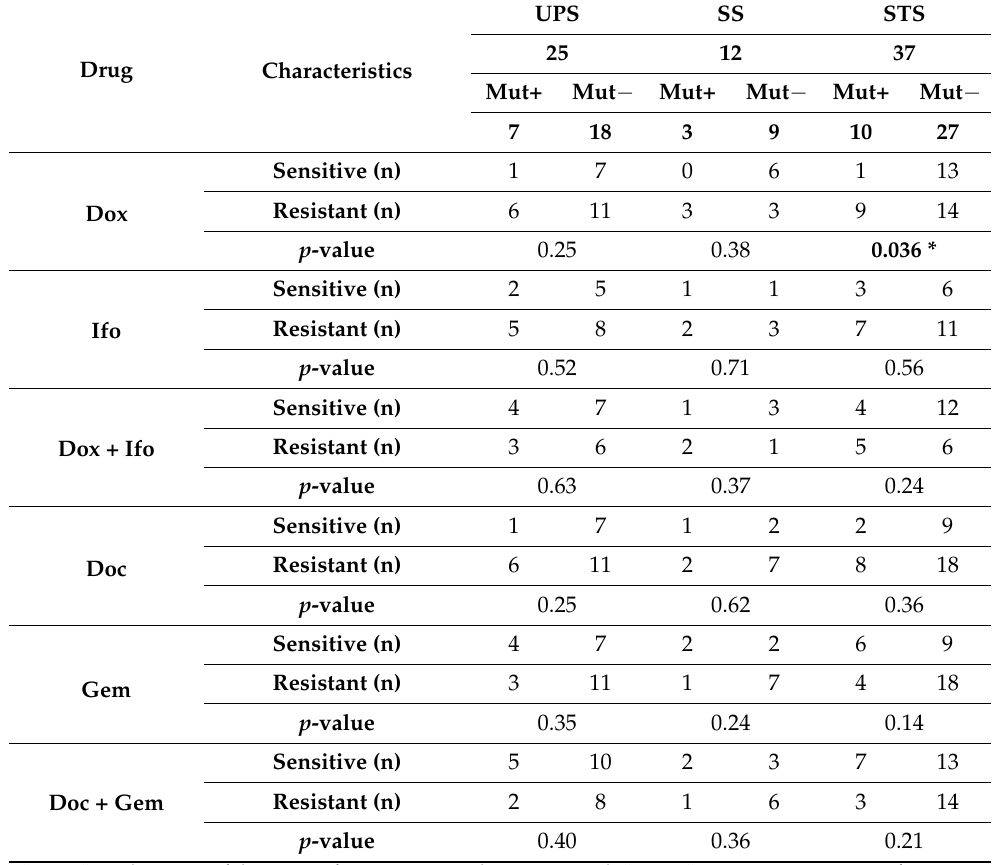
Table 4. Chemoresistance of cancer cells in the primary STS cultures depending on the somatic mutational status of apoptosis activation pathway genes